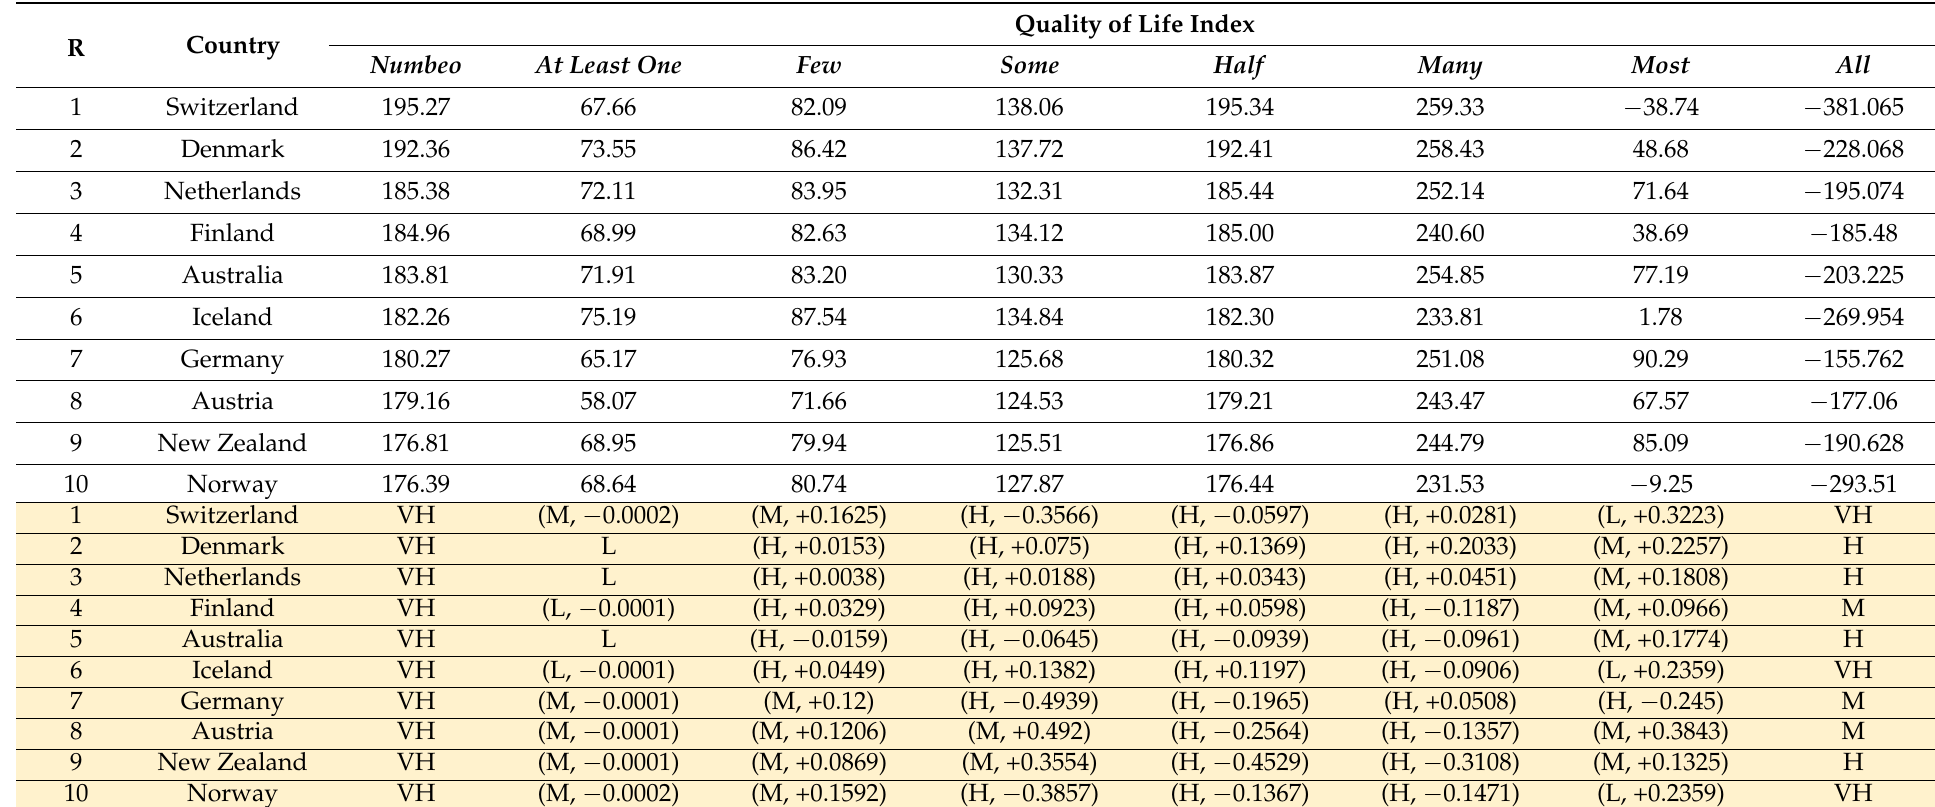
Table 7. Numbeo top 10 countries in terms of quality of life index (number versus. 2-tuple